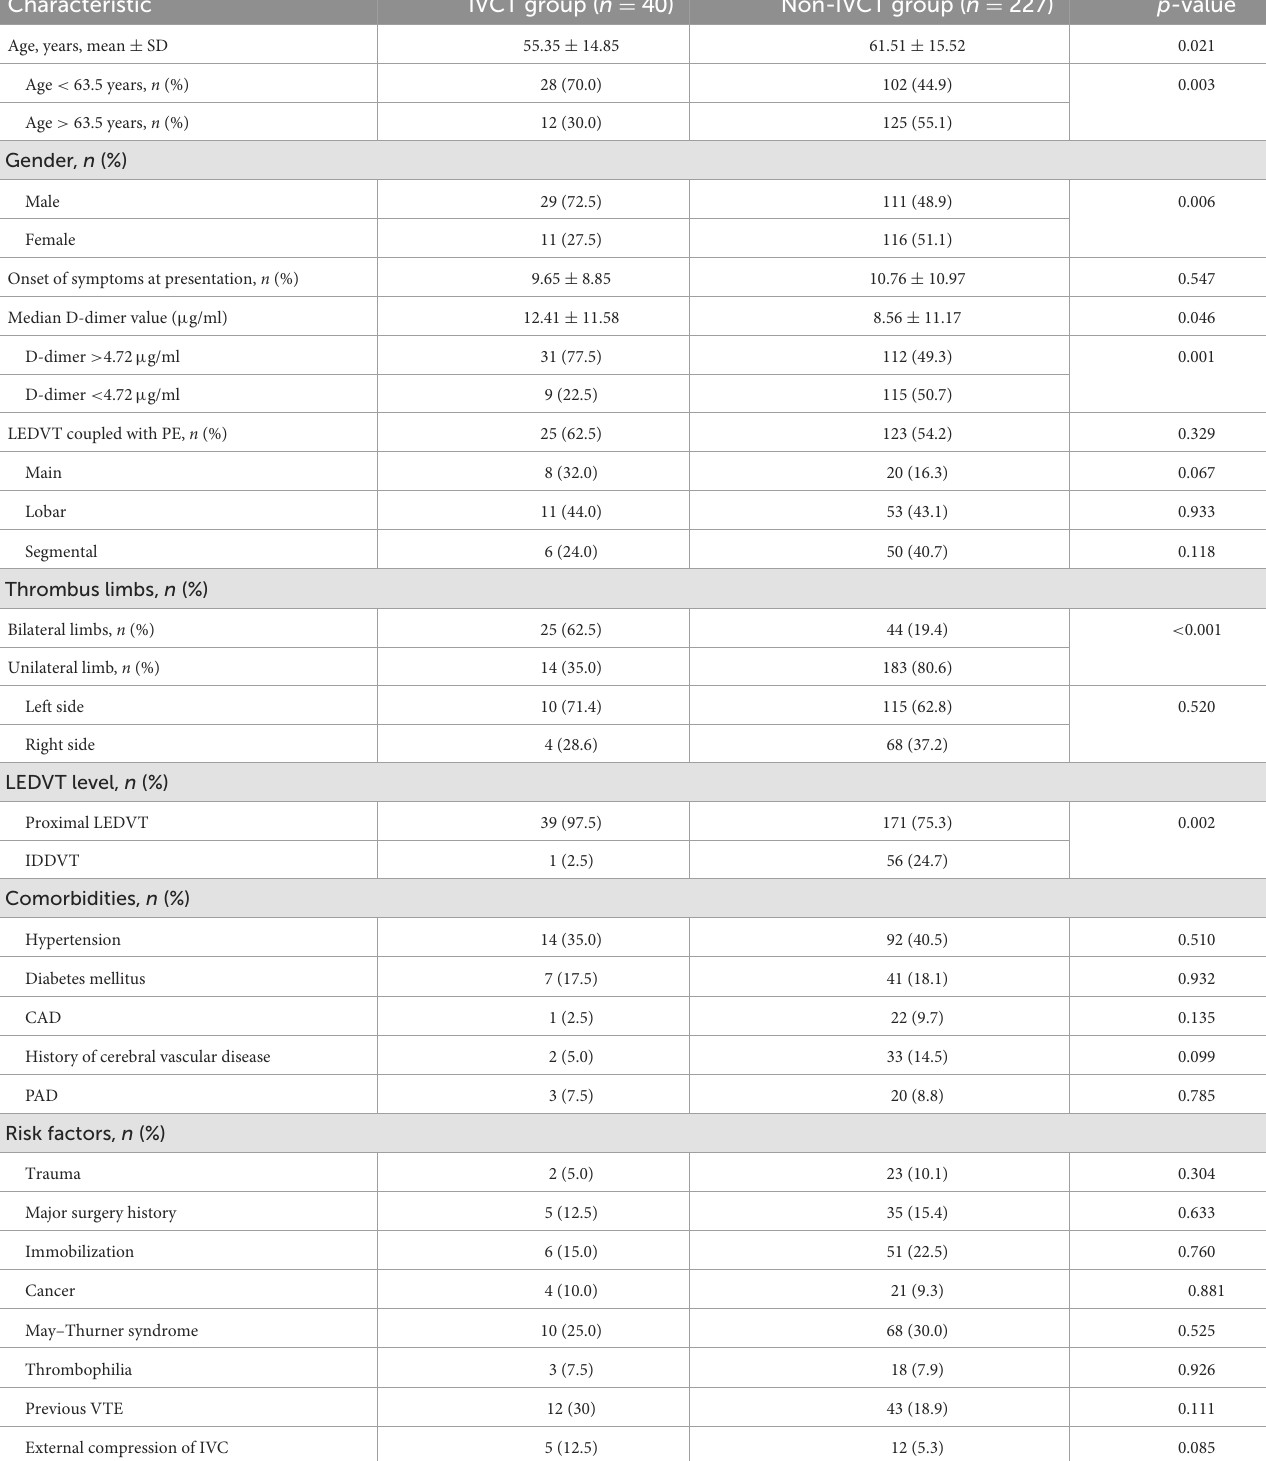
TABLE 1 Demographics, presentation, lesion characteristics, cancer conditions, comorbidities and risk factors of IVCT patients. Characteristic IVCT group ( n = 40) Non-IVCT group ( n =